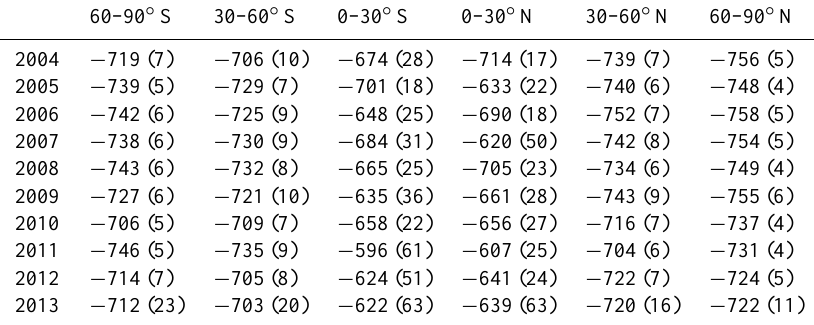
Table 1. Annual zonal values (2 σ uncertainties) of β